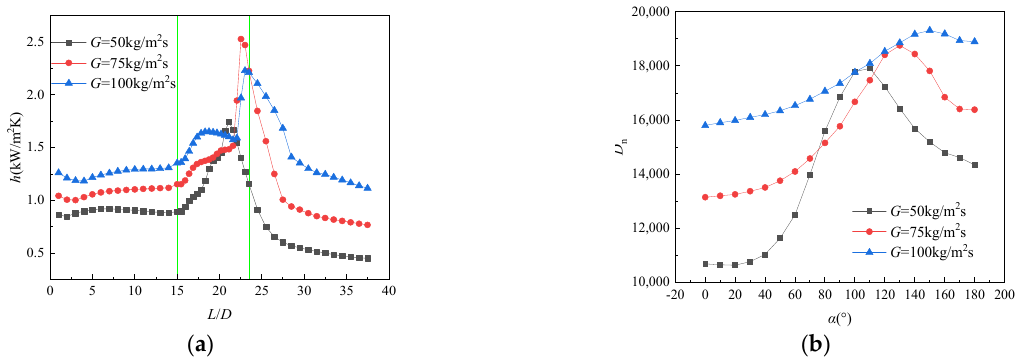
Figure 9. The changes in h with L / D and in Dn with α under different mass flux conditions: ( a ) L/D , ( b ) α (°).